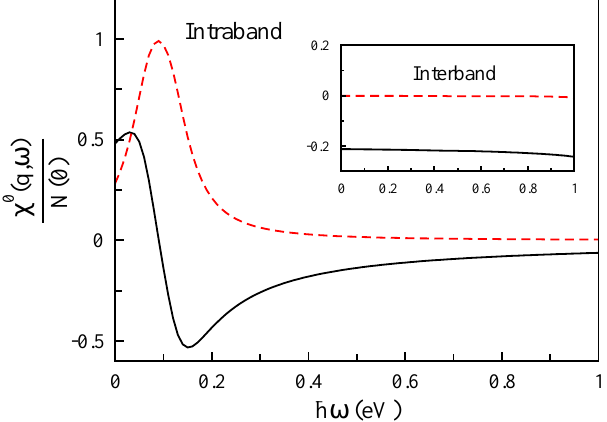
Figure 17. The real (solid line) and imaginary (dashed line) parts of interband and intraband contributions of the non-interacting response function of monolayer phosphorene in units of the Fermi-level density of states as a function of ¯ h ω for q = 0.046 Å − 1 along the armchair